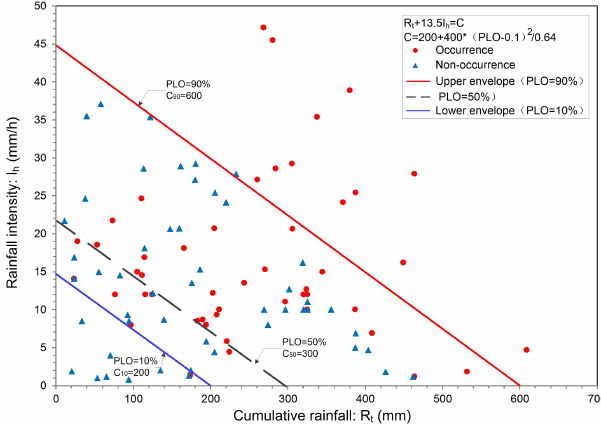
Figure 4. R t –I h graph for occurrence (red points) and non- occurrence (blue triangular points) of landslide events in the Huang- shan region based on historical rainfall